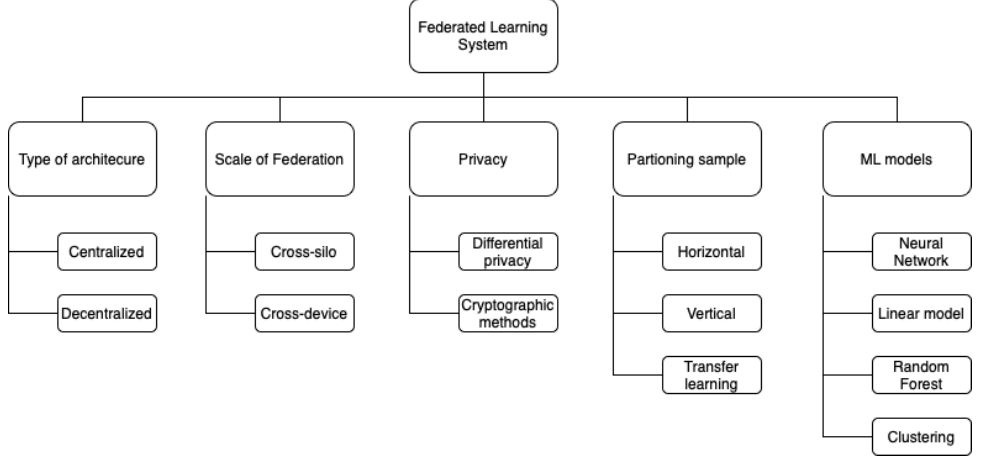
Figure 1. Taxonomy of FL